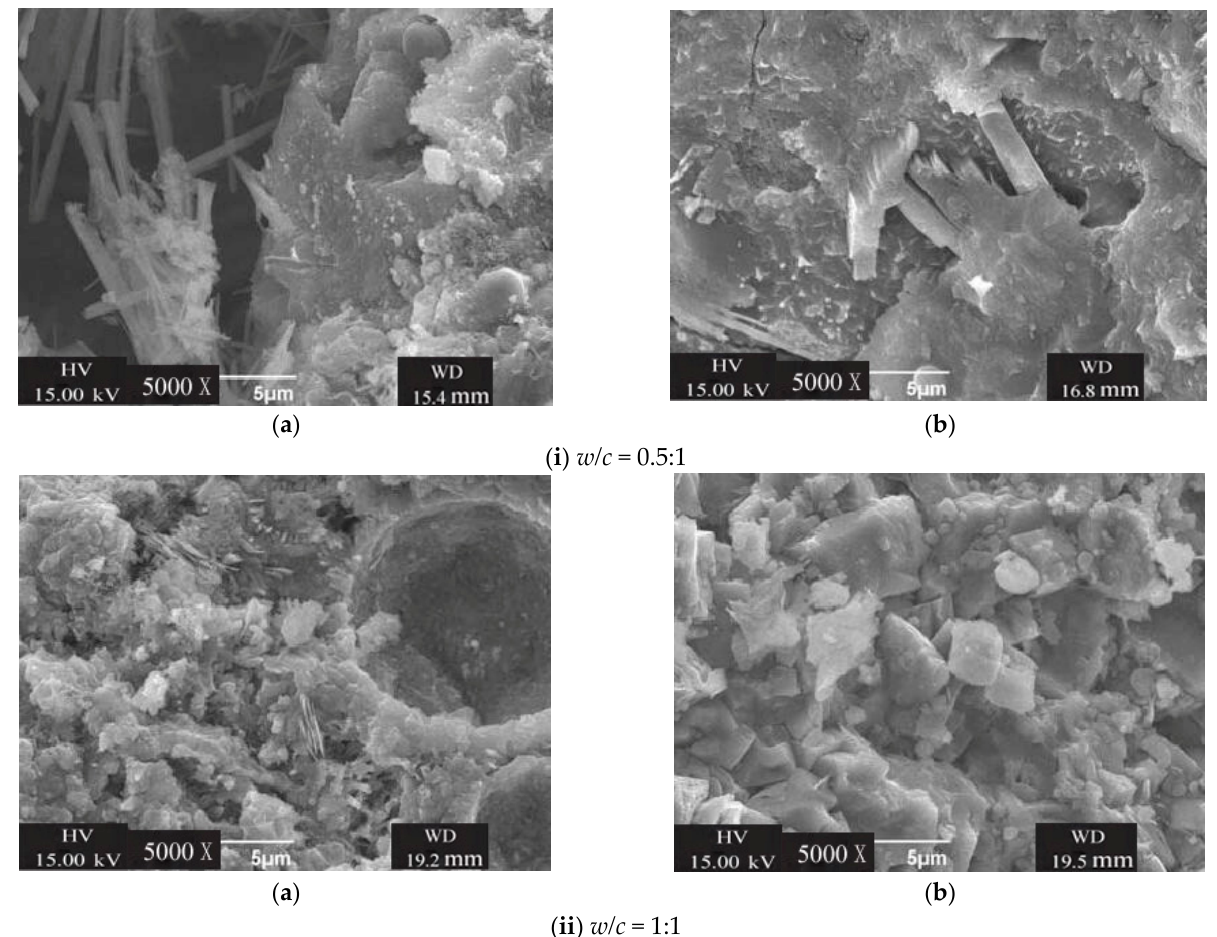
Figure 13. The values of λ of hardened cement grouts.